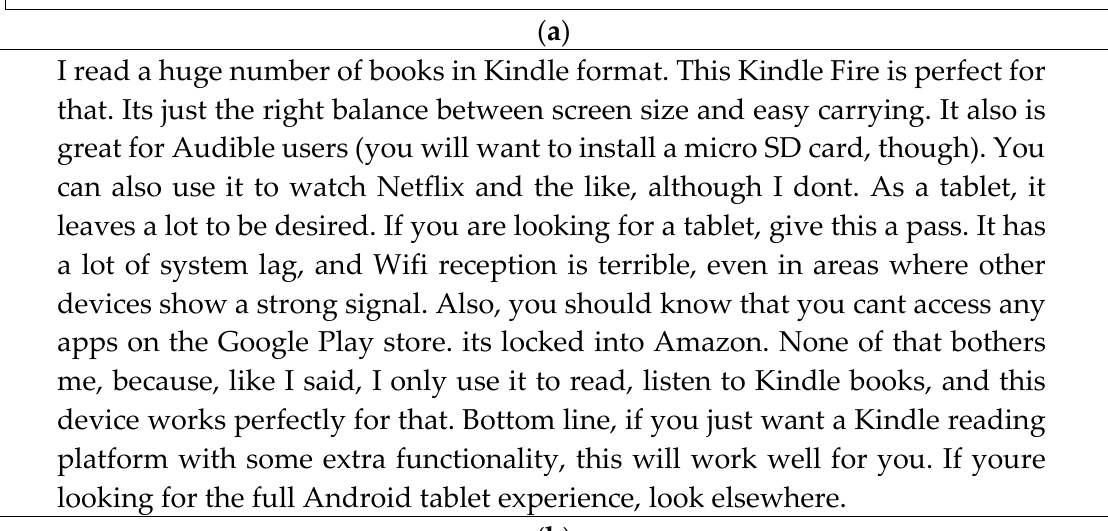
Figure 3. This figure shows a test-sample of the model against a review paragraph: ( a ) paragraph without punctuation; ( b ) restored paragraph punctuation using model.